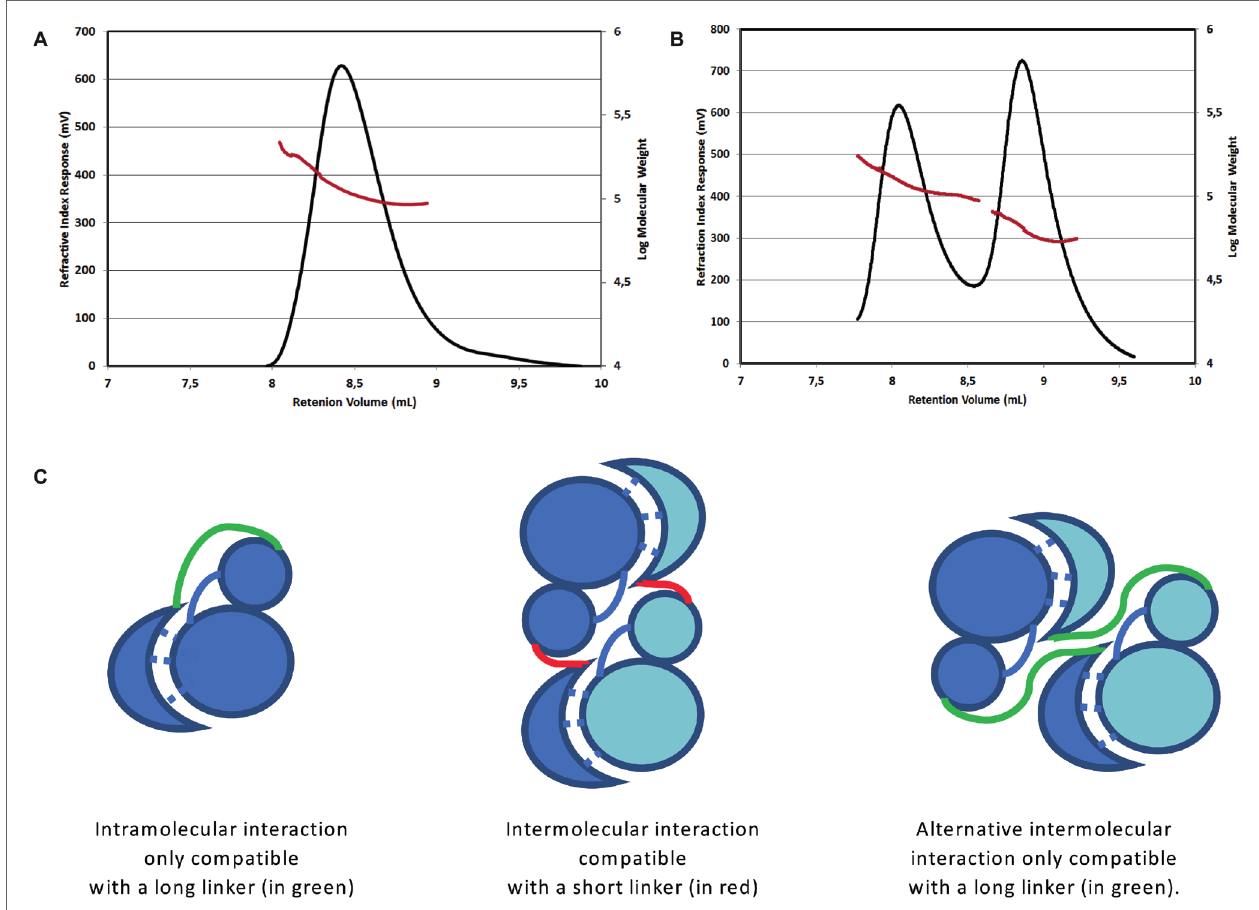
FIGURE 1 | Oligomerization state of the short and long forms of the bE8-YabT( ∆ TM) fusion protein. SEC-MALS analysis of the short form injected at 3 mg/ml (A) and of the long form injected at 4 mg/ml (B) . The short form was eluted as a single peak corresponding to a dimer of about 115 kDa. The long form was eluted as two main peaks, which were analyzed as an equilibrium between a monomer of about 60 kDa and a dimer of about 120 kDa. An additional small peak suggested the formation of a tetramer. The two main peaks were analyzed separately but are displayed on the same graph. The elution profiles are represented according to retention volume (in ml) with the refractive index (in mV) indicated on the left axis (black curve) and the logarithm of molecular weight on the right axis (red curve). (C) Models of the intra- and inter-molecular interactions of the bE8 and YabT( ∆ TM) domains of the fusion proteins. The linker between bE8 and the bilobal kinase domain is shown in red for the short form and in green for the long form. The specific contacts between bE8 and YabT are shown as dashed lines. A subunit is colored in dark blue and the other one in pale